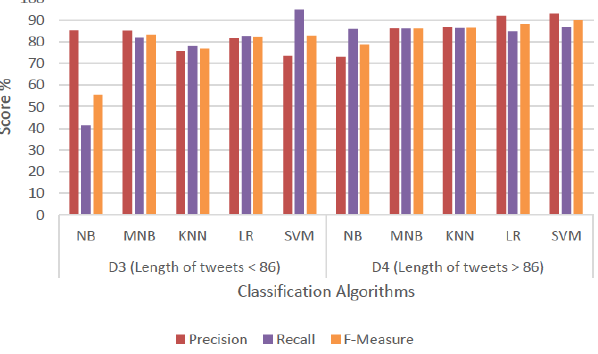
Figure 7: Sentiment prediction based on the length of